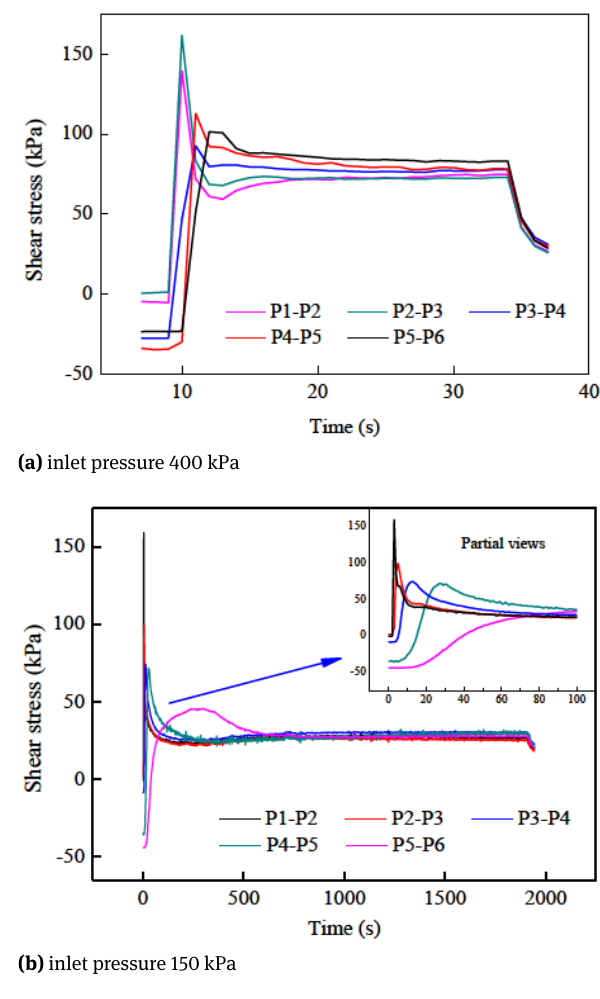
Figure 11: Shear stress of crude oil between adjacent pressure transducers